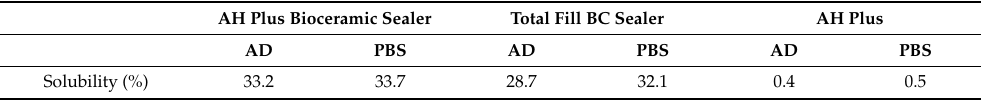
Table 2. Solubility of AH Plus Bioceramic Sealer, Total Fill BC Sealer, and AH Plus after 24 h in AD according to ISO 6876, and in PBS.